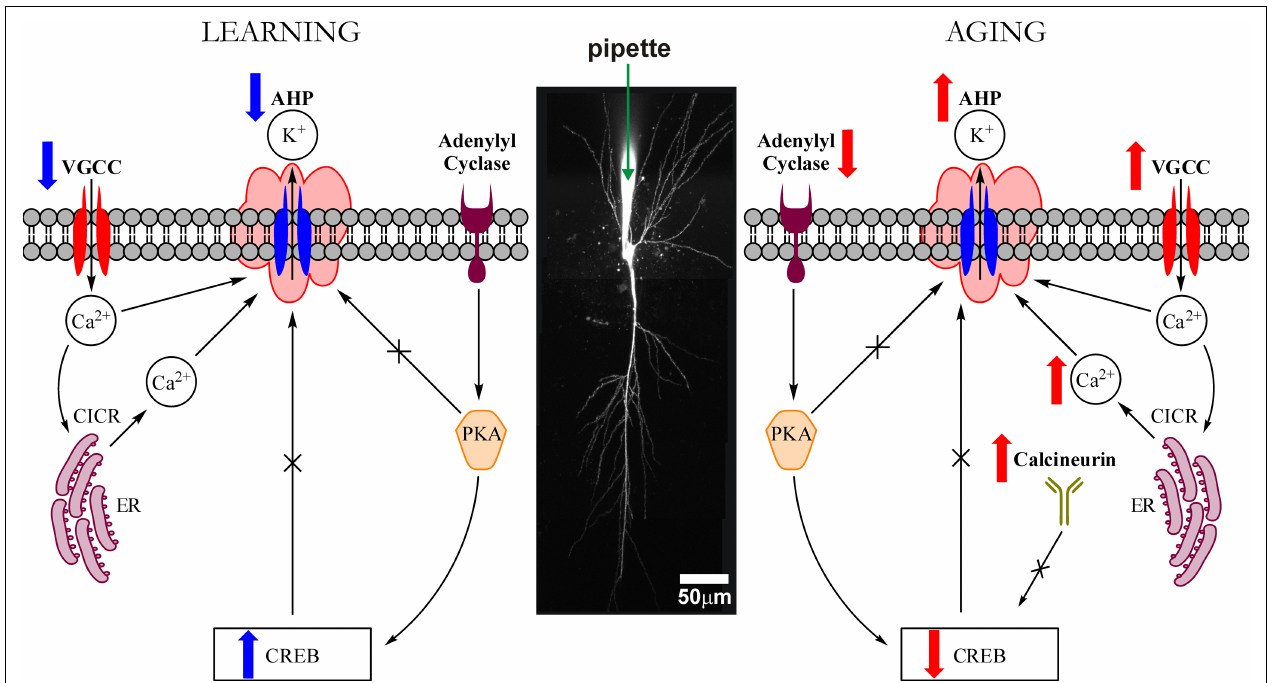
FIGURE 4 | Highly simplifi ed schematic of cellular signaling mechanisms that modulate the intrinsic excitability (i.e., the postburst AHP) of hippocampal pyramidal neurons during learning and with aging. The postburst AHP is a cellular response mechanism to a burst of action potentials that reduces the membrane potential (makes it more hyperpolarized) and to prevent the neuron from fi ring more action potentials. The postburst AHP has been consistently found to be altered during learning and with aging, making it an ideal cellular “biomarker” of intrinsic excitability change. The postburst AHP is activated by Ca 2 + ions that enter the cell via VGCCs and those that are released from the ER via Ca 2 + -induced Ca 2 + release (CICR) mechanisms. We have recent evidence that suggests that the protein levels of L-type VGCCs are signifi cantly reduced in CA1 region after successful learning (Nunez-Santana et al., 2009) which could contribute to the learning-related postburst AHP reduction. We also have shown that PKA activity is involved in mediating the learning-related postburst AHP reduction (Oh et al., 2009). The postburst AHP has also been shown to be reduced by CREB activation (Lopez de Armentia